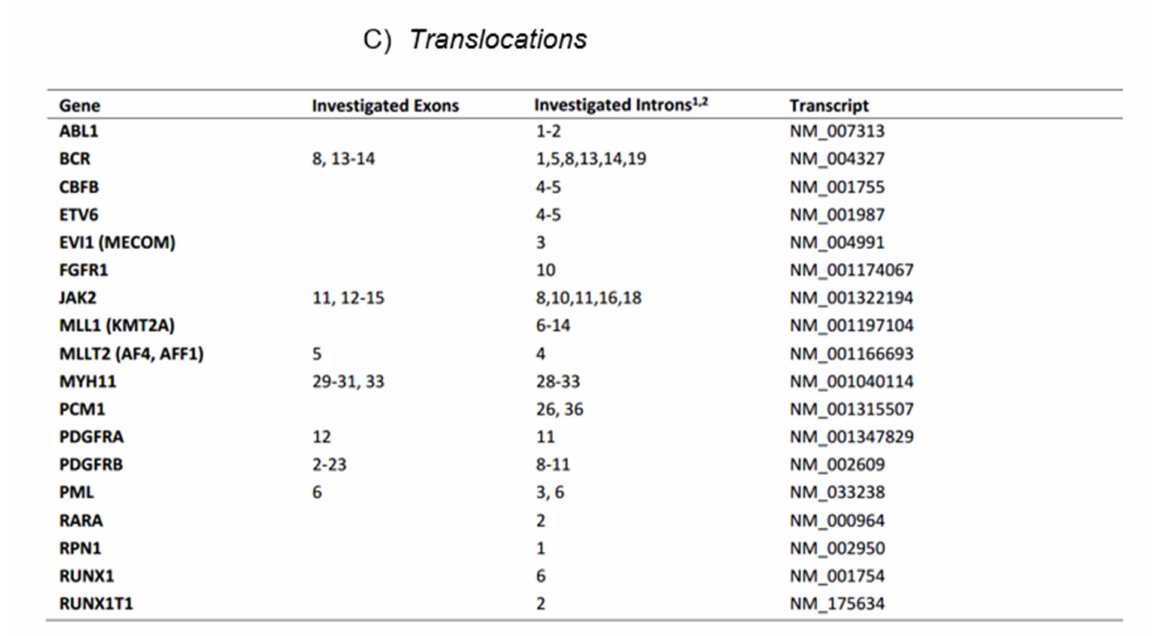
Figure 1. The current myeloid next-generation sequencing panel. ( A ) Coverage of exome hotspot regions. ( B ) Point mutations, small insertions, and deletions. ( C ) Translocations.